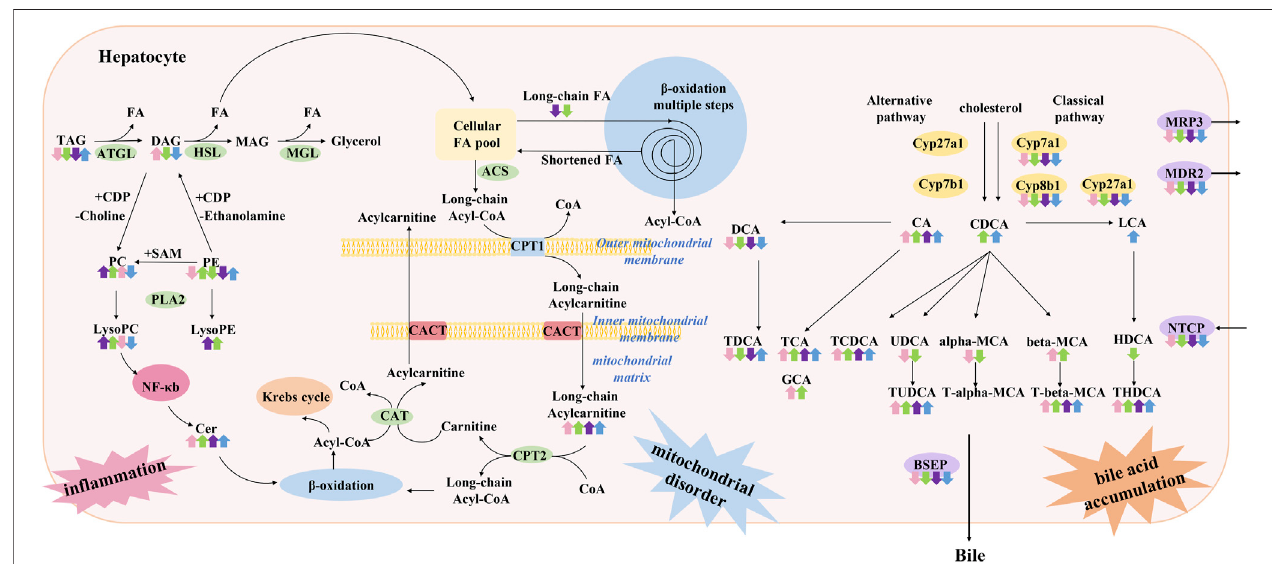
FIGURE11| Summaryofcharacteristicsoflipidandbileacidmetabolismdisordersinmodelsofacutecholestaticliverdiseaseinthisstudy.Itisspeculatedthatthe pathogenesis of thisdisease is related tohepatocyte in fl ammation caused by lipid metabolism disorder and toxic bileacid accumulation caused by bile acidmetabolism disorder.Thefourcoloredarrowsindicatetheup-regulationordown-regulationofthesubstanceinANIT(pinkarrow)group,DDC(greenarrow)group,EE(purplearrow) group, and LCA (blue) group. ATGL: Adipose triglyceride lipase, HSL: Hormone-sensitive lipase, MGL: Monoacylglycerol lipase, PLA2: Phospholipase A2, ACS: Acetyl-CoA synthase, CPT1: Carnitine palmitoyl transferase 1, CPT2: Carnitine palmitoyl transferase 2, CACT: Carnitine acyl transferase.